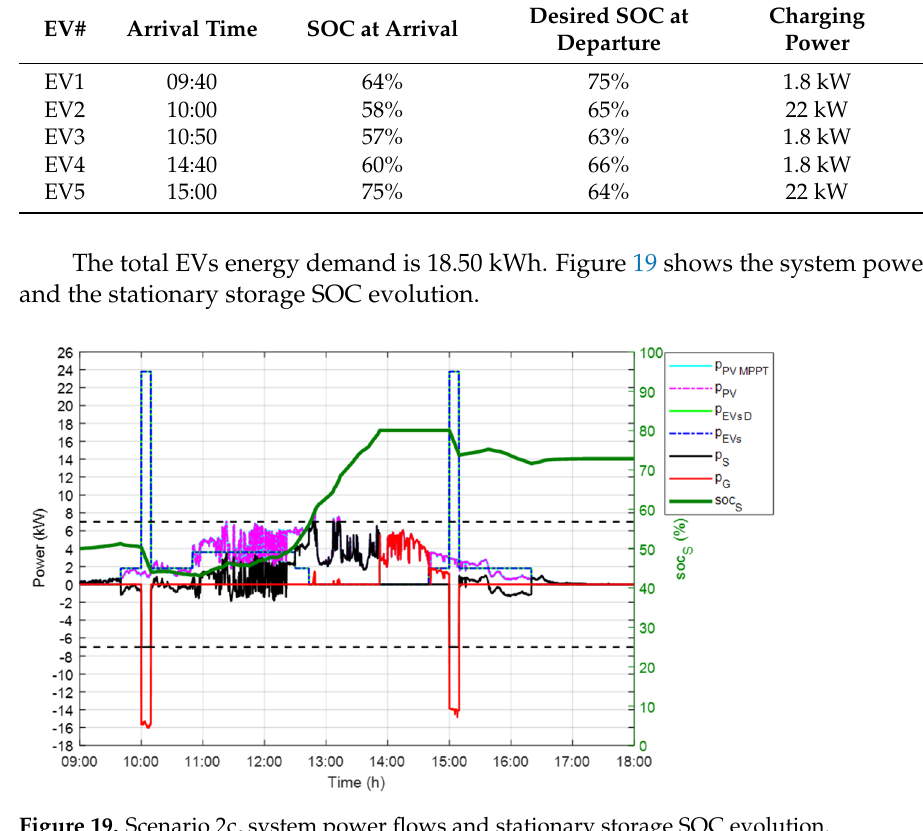
Table 5. Hypotheses for Scenario 2c.